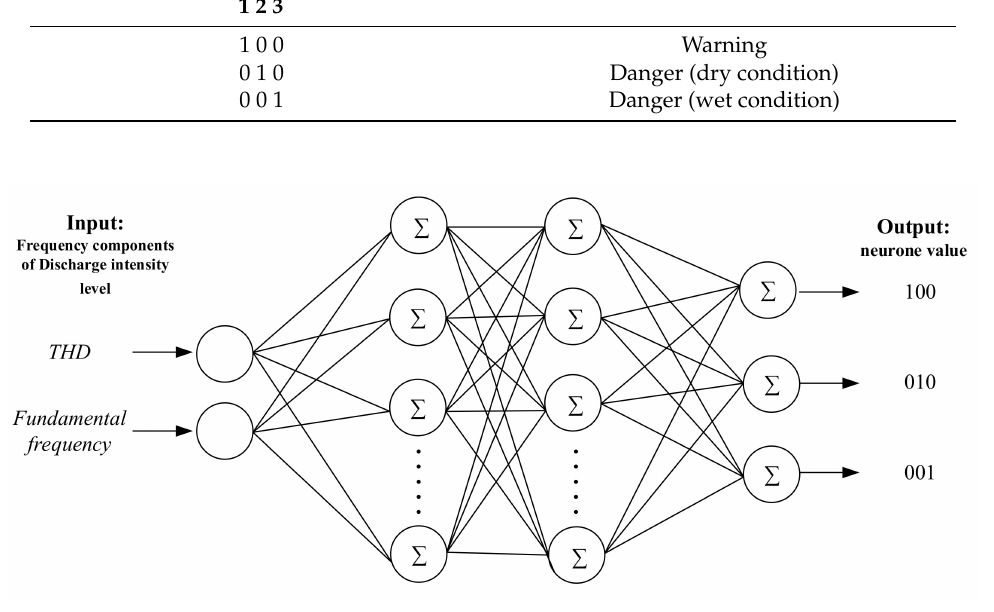
Figure 5. ANN architecture.